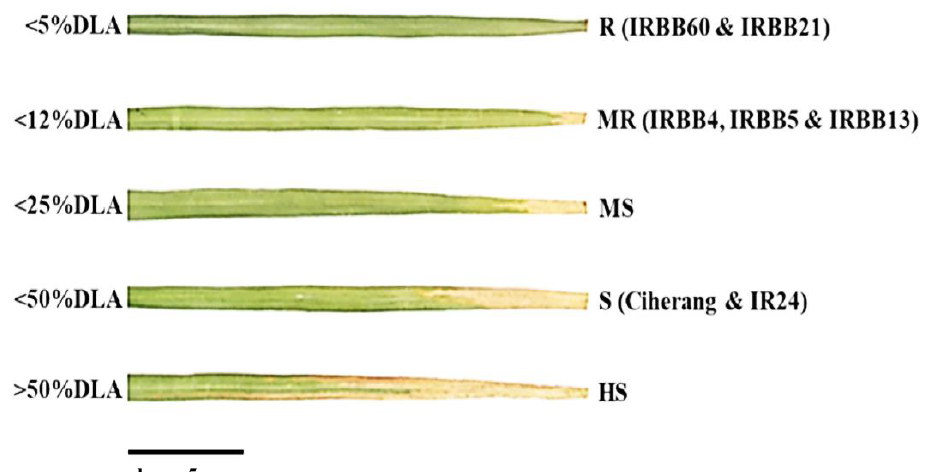
Figure 1. Disease scoring of infected leaves fourteen days after inoculation with three BB races. DLA—diseased leaf area, R—resistant, MR—moderately resistant, MS—moderately susceptible, S—susceptible, HS—highly susceptible.